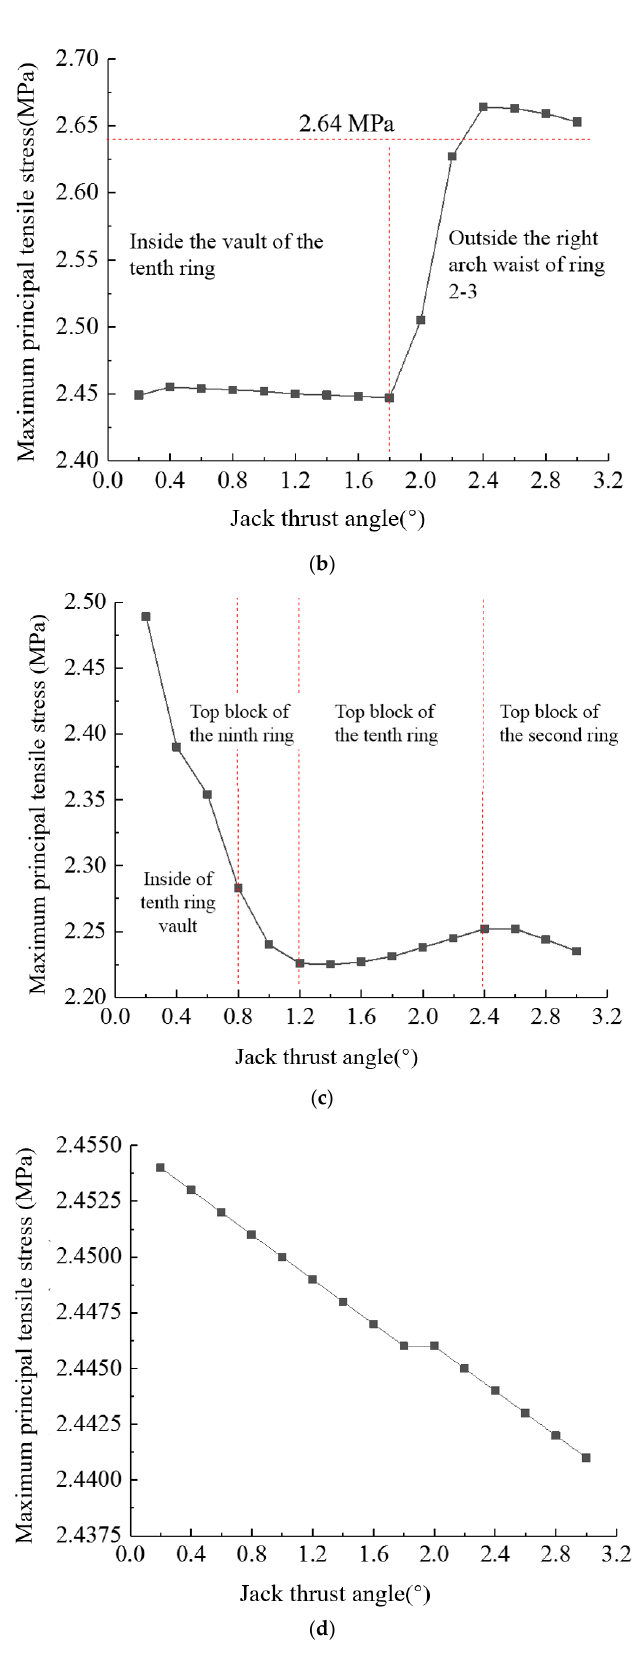
Figure 18. Stress of tunnel and bolt. ( a ) Stress of bolt. ( b ) Stress of tunnel in upward direction. ( c ) Stress of tunnel in downward direction. ( d ) Stress of tunnel in left